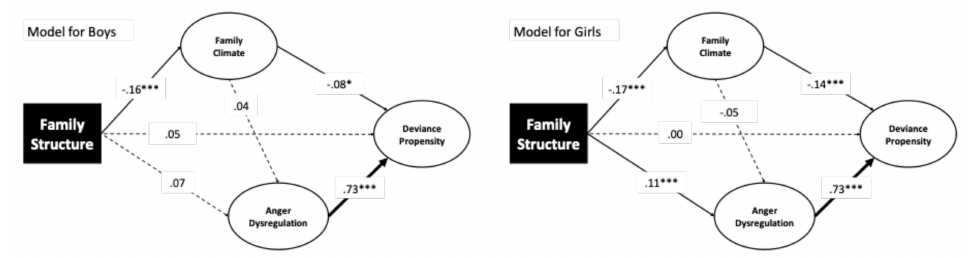
Figure3. Multigroupanalysisofthemodeltestedwithgenderasagroupingvariable. Notes:*** p <